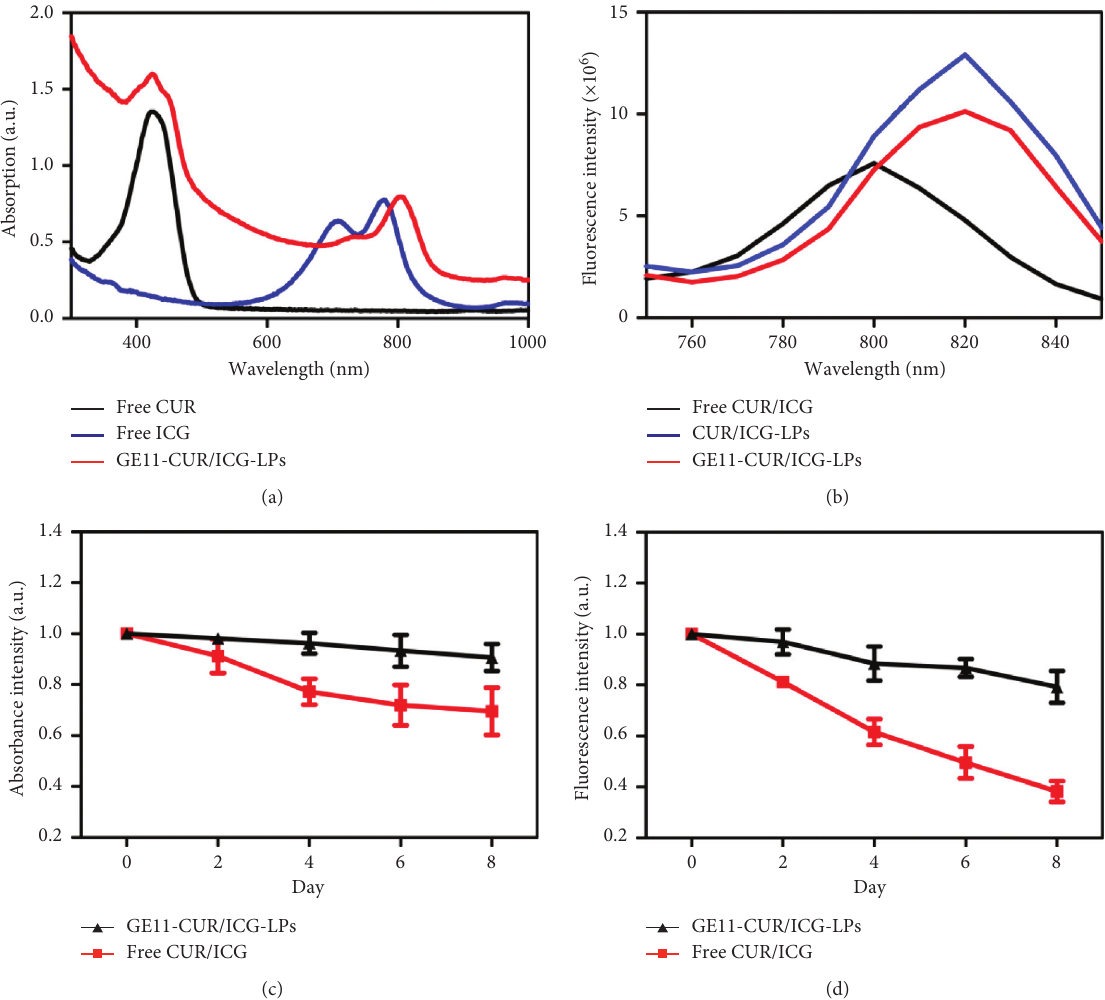
Figure 2: (a) Absorption spectrum of free ICG, free CUR, and GE11-CUR/ICG-LPs. (b) Fluorescence spectrum of free CUR/ICG, CUR/ ICG-LPs, and GE11-CUR/ICG-LPs with the excitation wavelength of 700nm. (c) The absorbance and (d) fluorescence changes of free CUR/ ICG and